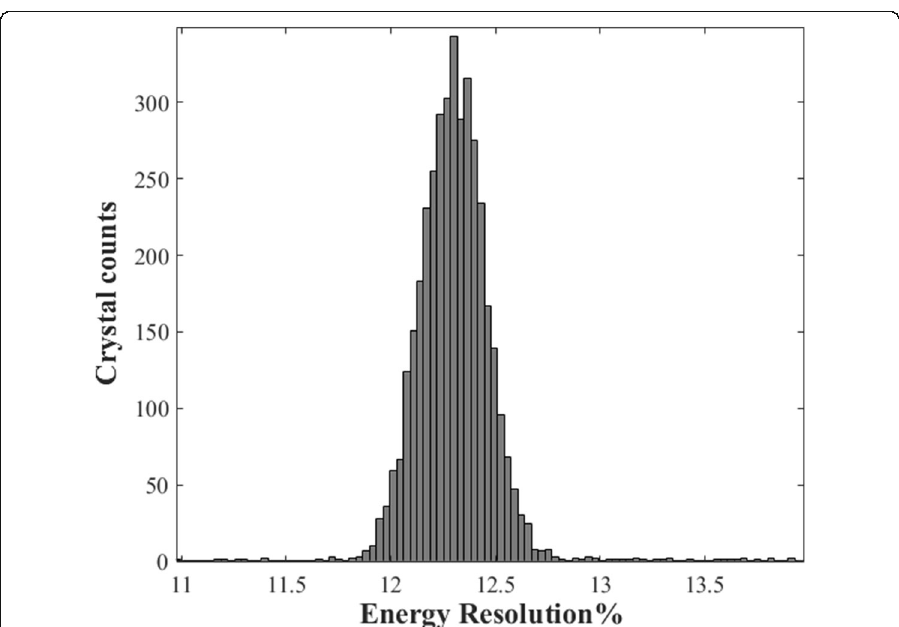
Fig. 5 Energy resolution histogram of individual crystals